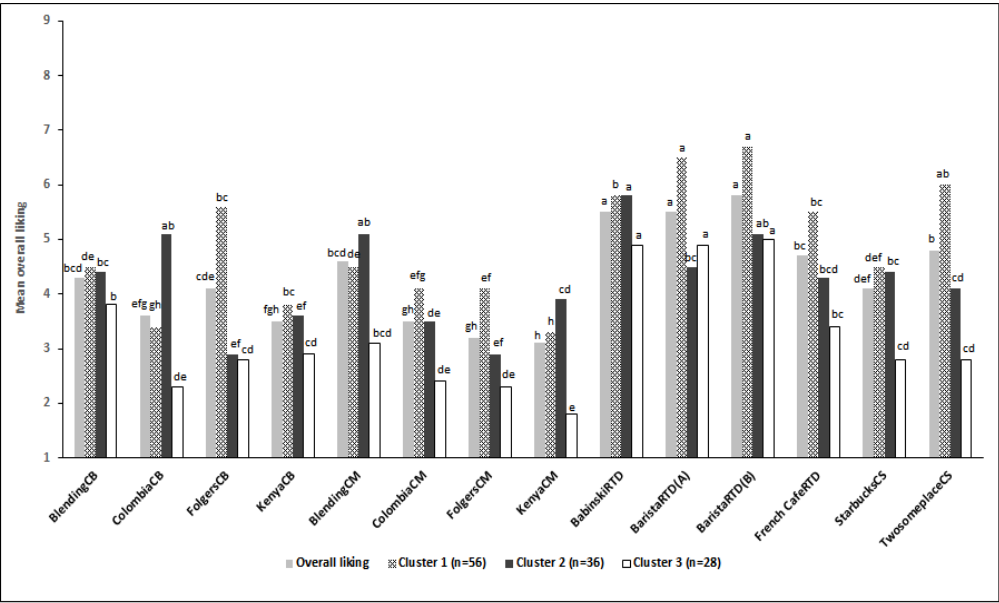
Figure 3. Overall liking of coffee by three consumer clusters.